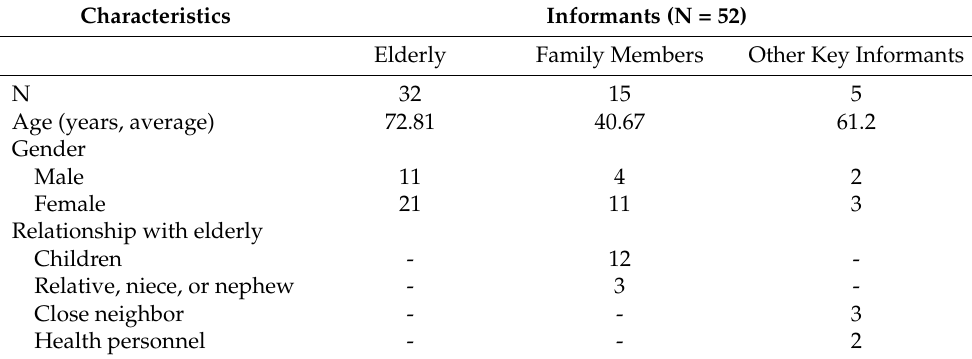
Table 1. Informants’